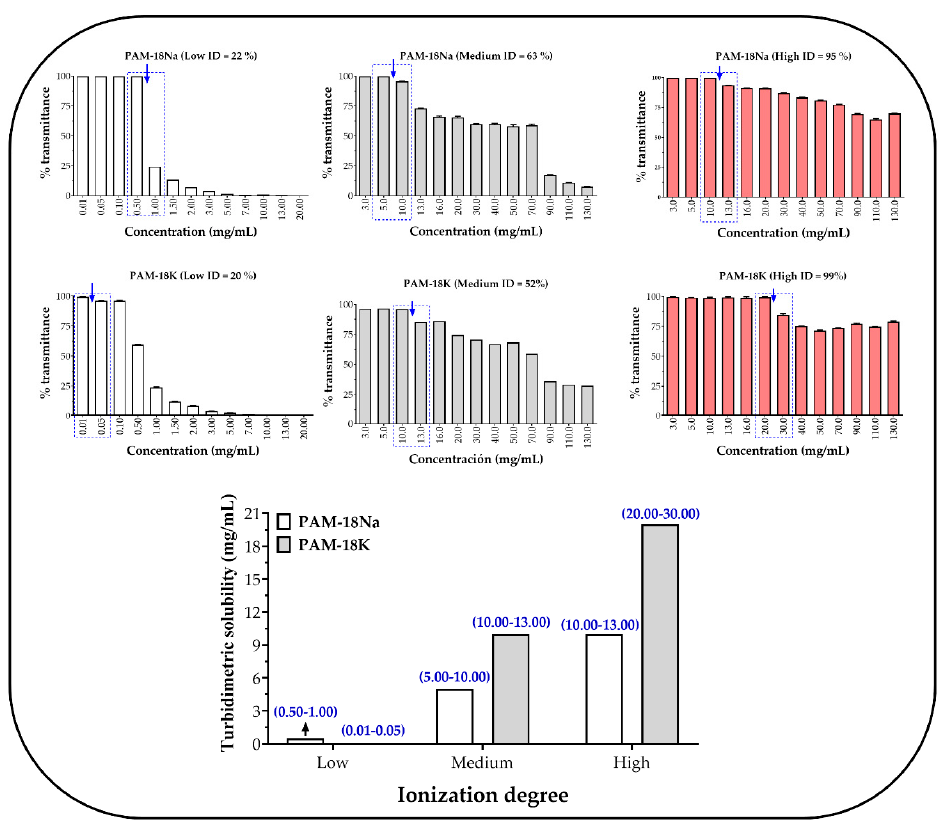
Figure 1. Values of turbidimetric solubility for PAM-18Na and PAM-18K polyelectrolytes with different ionization degree (ID) in aqueous media. ionization degree (ID) in aqueous